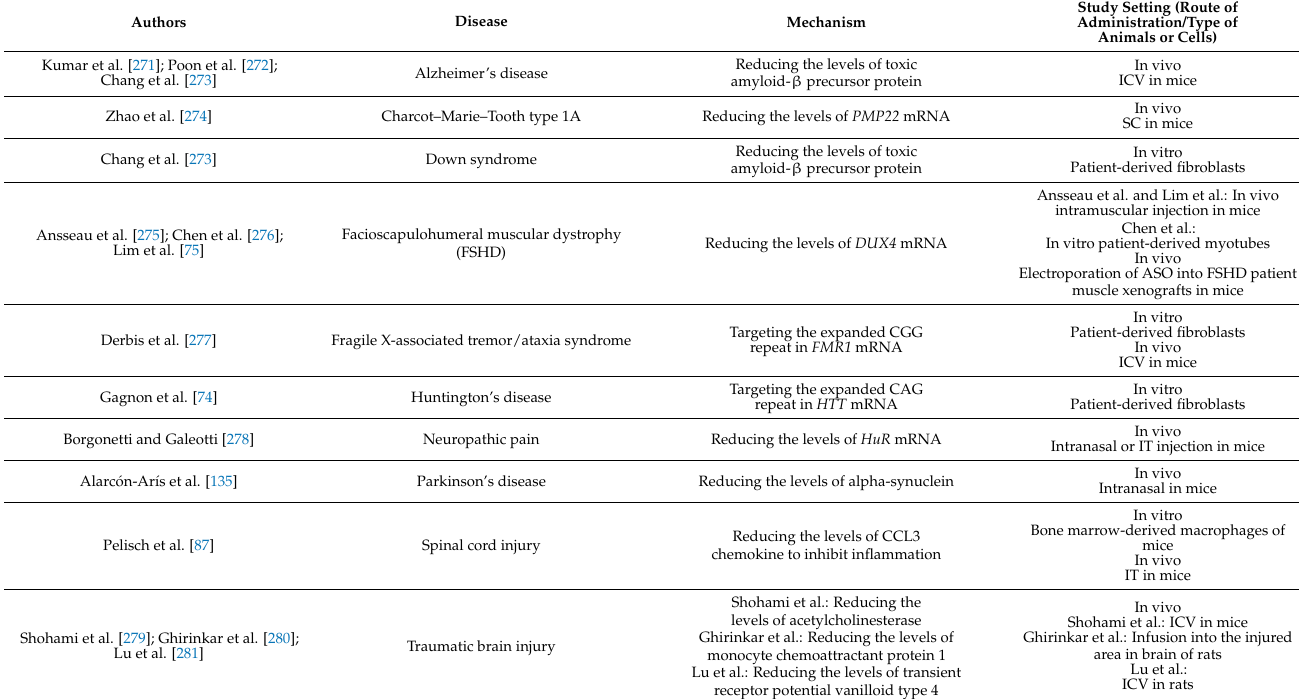
Table 4. Preclinical studies reporting the therapeutic effects of antisense oligonucleotides with new target mRNAs in neurological